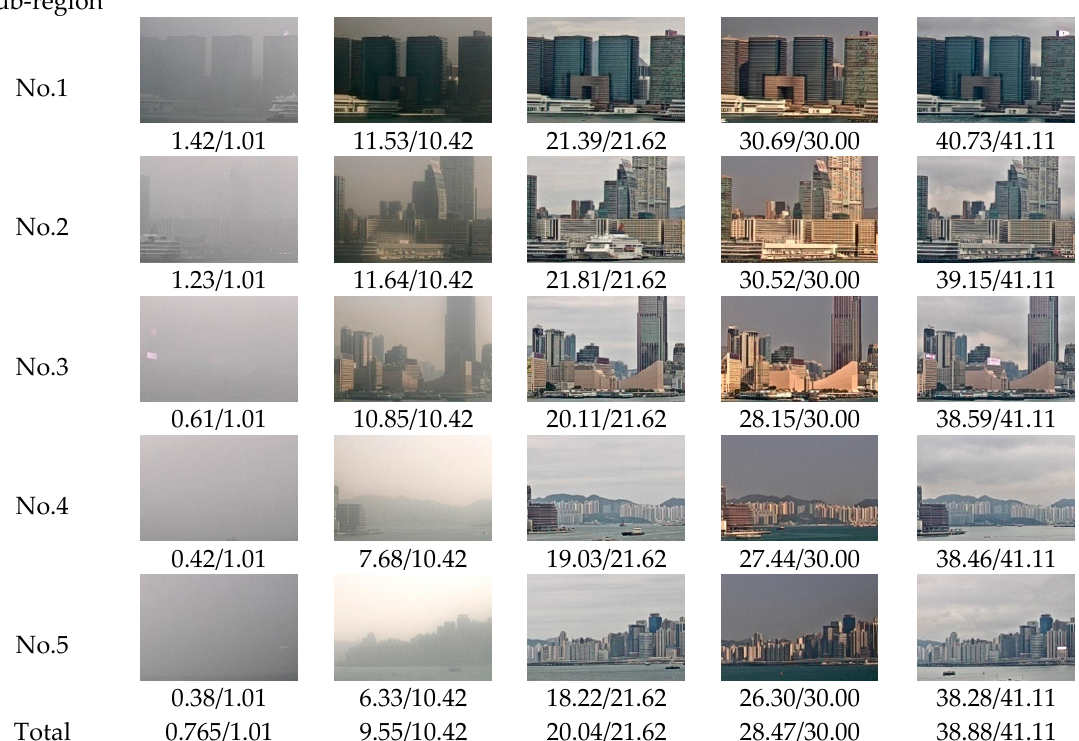
Figure 10. Example images of five subregions at different visibility range.